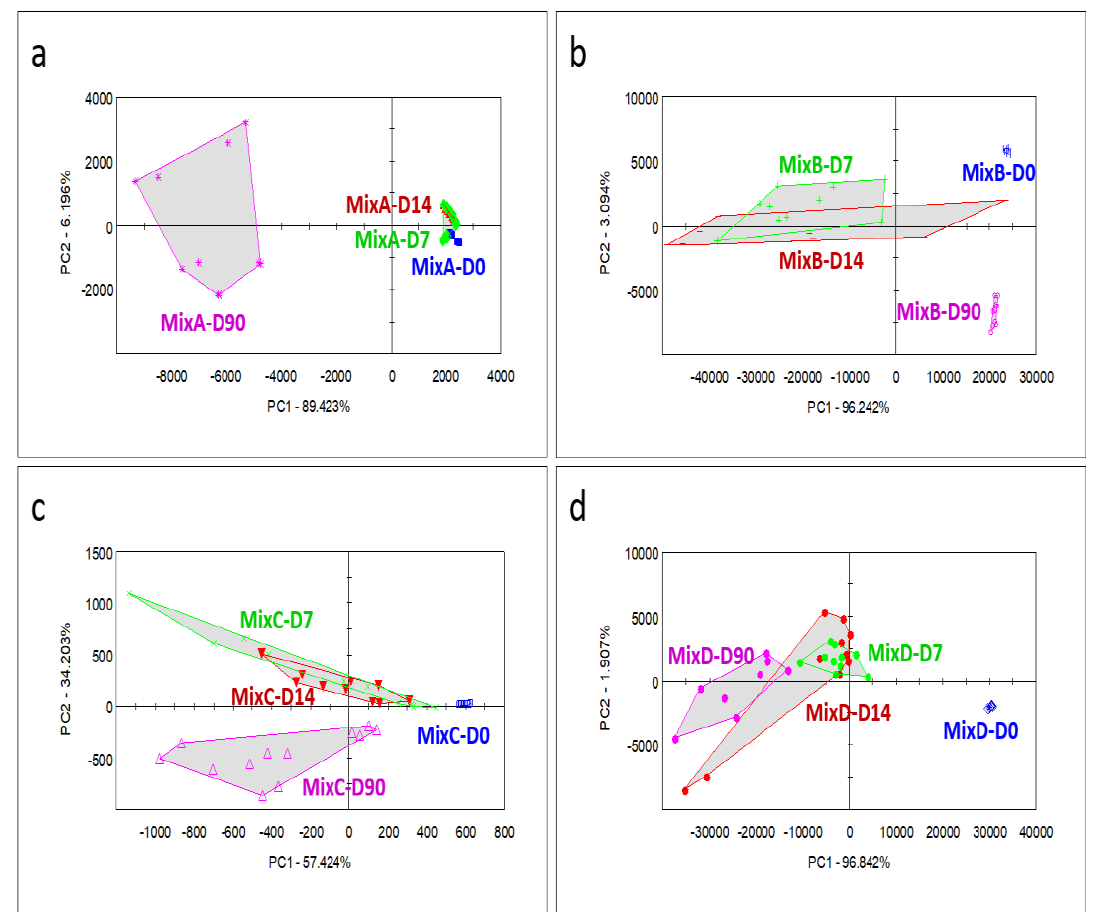
Figure 3. PCA score plots calculated from the aroma profiles of mixture A ( a ), mixture B ( b ), mixture C ( c ) and mixture D ( d ), indicating the fermentation days (Days 0, 7, 14, 90) within each plot.